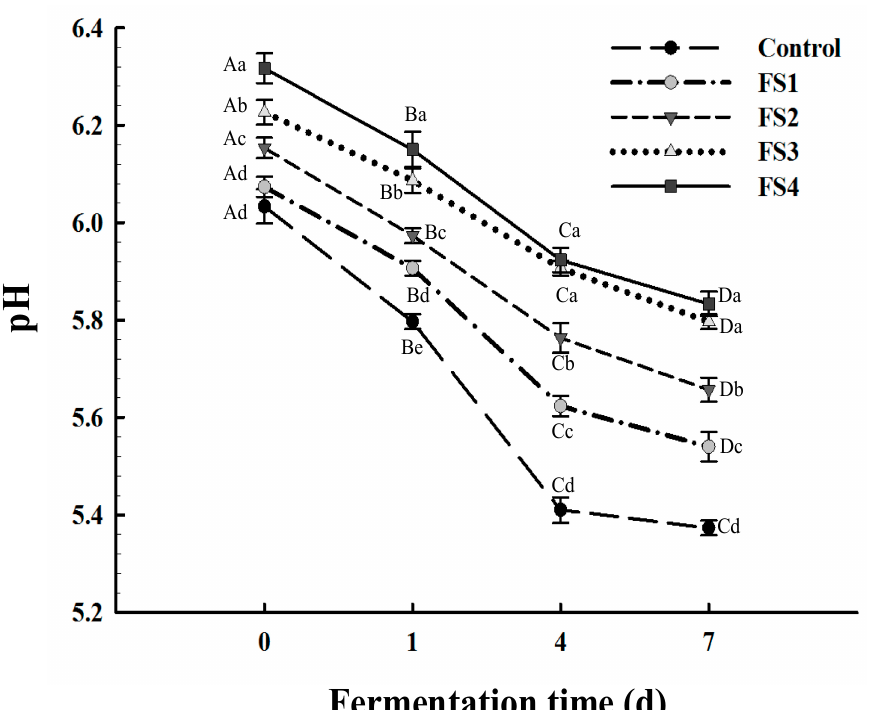
Figure 1. Changes in pH of Harbin dry sausages with different replacement levels of CFS during fermentation. Control: 100% backfat; FS1: 80% backfat and 20% CFS; FS2: 60% backfat and 40% CFS; FS3: 40% backfat and 60% CFS; FS4: 20% backfat and 80% CFS. Different lowercase letters (a–d) mean significant differences among the treatments ( p < 0.05). Different uppercase letters (A–D) mean significant differences among different fermentation times ( p < 0.05).